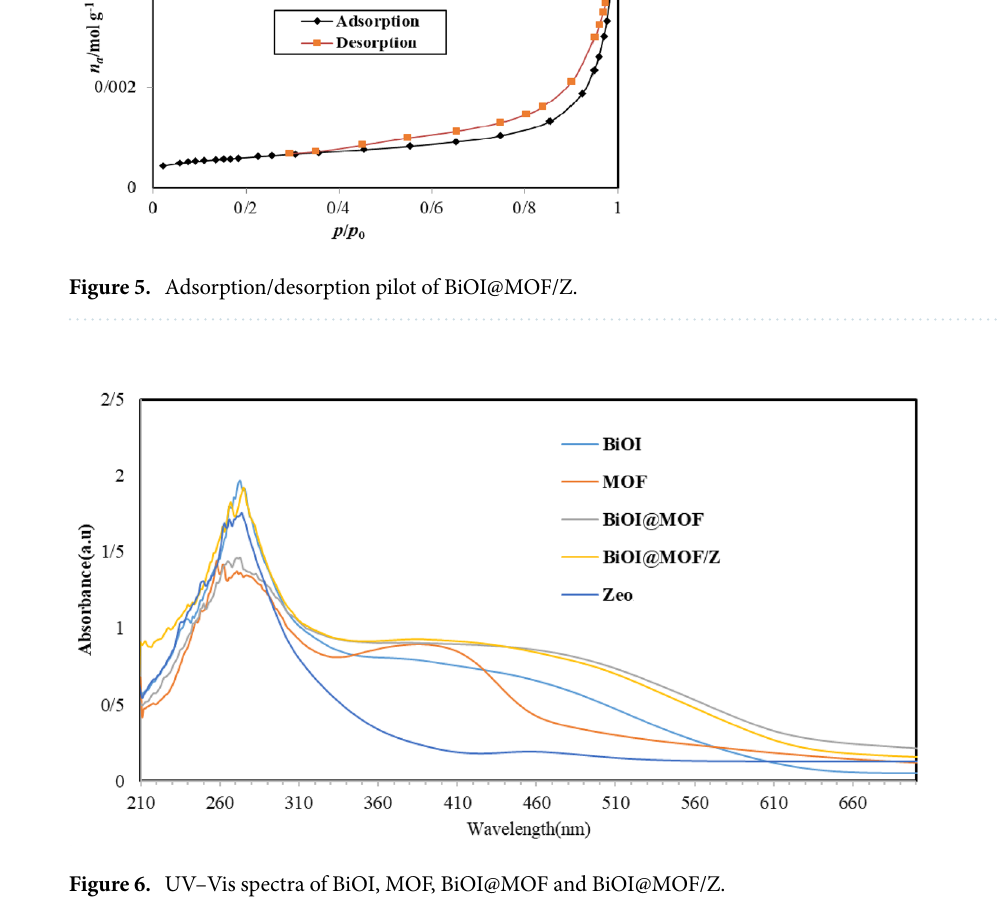
Figure 6. UV–Vis spectra of BiOI, MOF, BiOI@MOF and